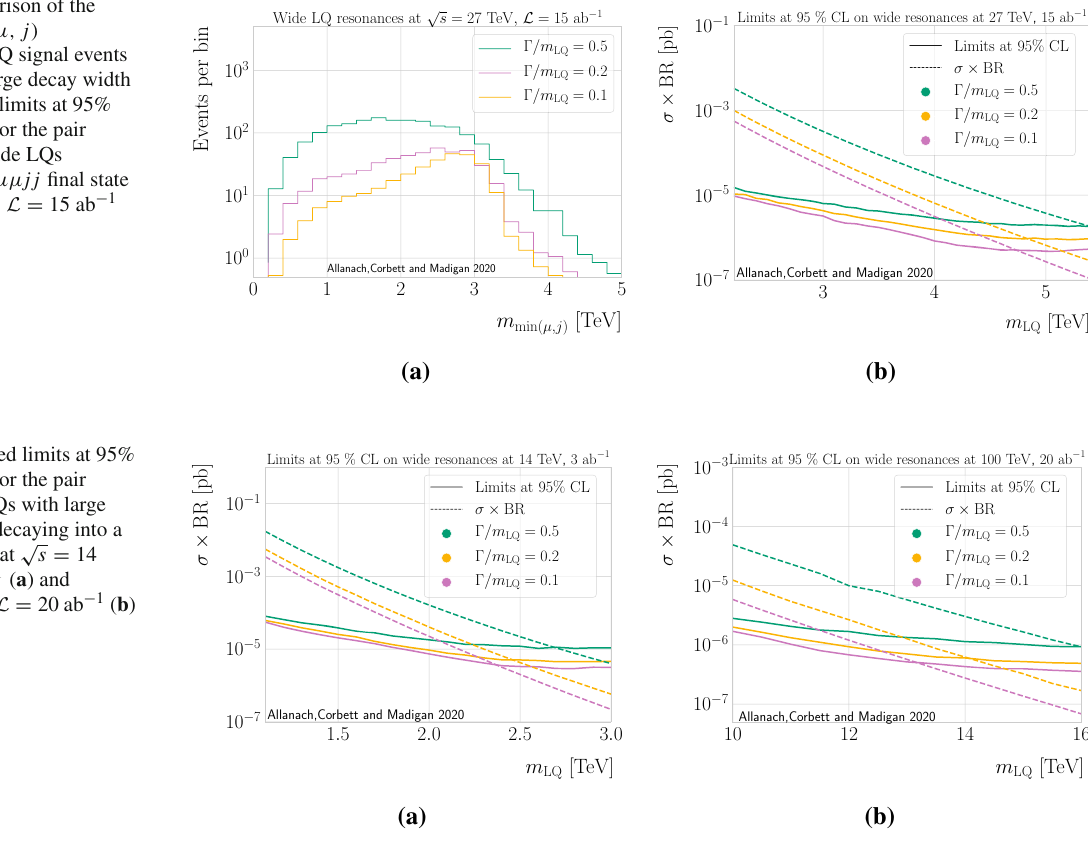
Fig. 15 Comparison of the predicted m min (μ, j ) distribution of LQ signal events for a LQ with large decay width (cid:14) ( a ). Expected limits at 95% CL on σ × BR for the pair production of wide LQs decaying into a μμ jj final state √ s = 27 TeV, L = 15 ab − 1 at ( b ).